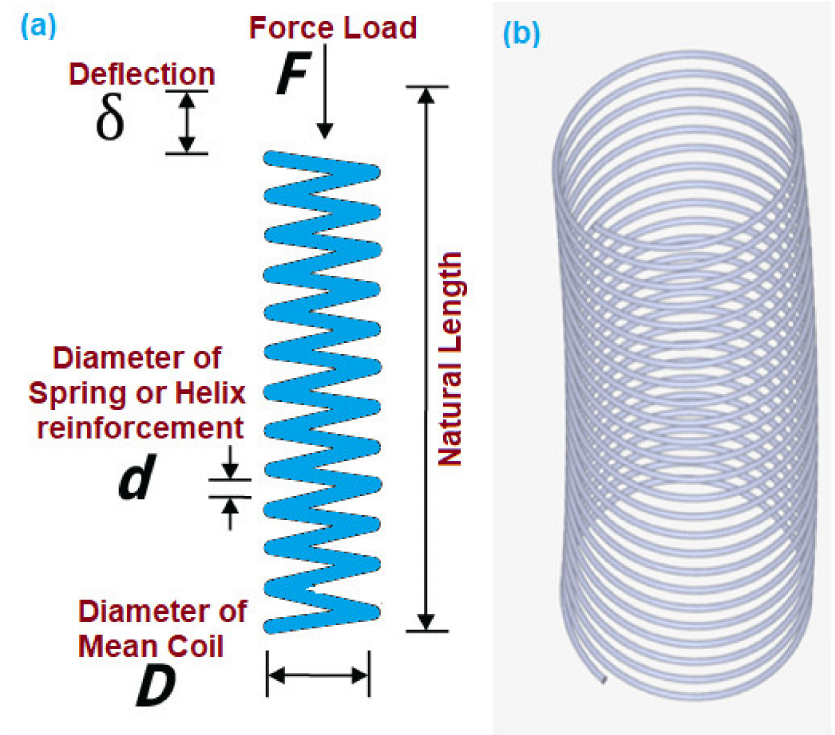
Figure 8. Schematic, showing ( a ) notation for helix spring, and ( b ) the reinforcement helix model.